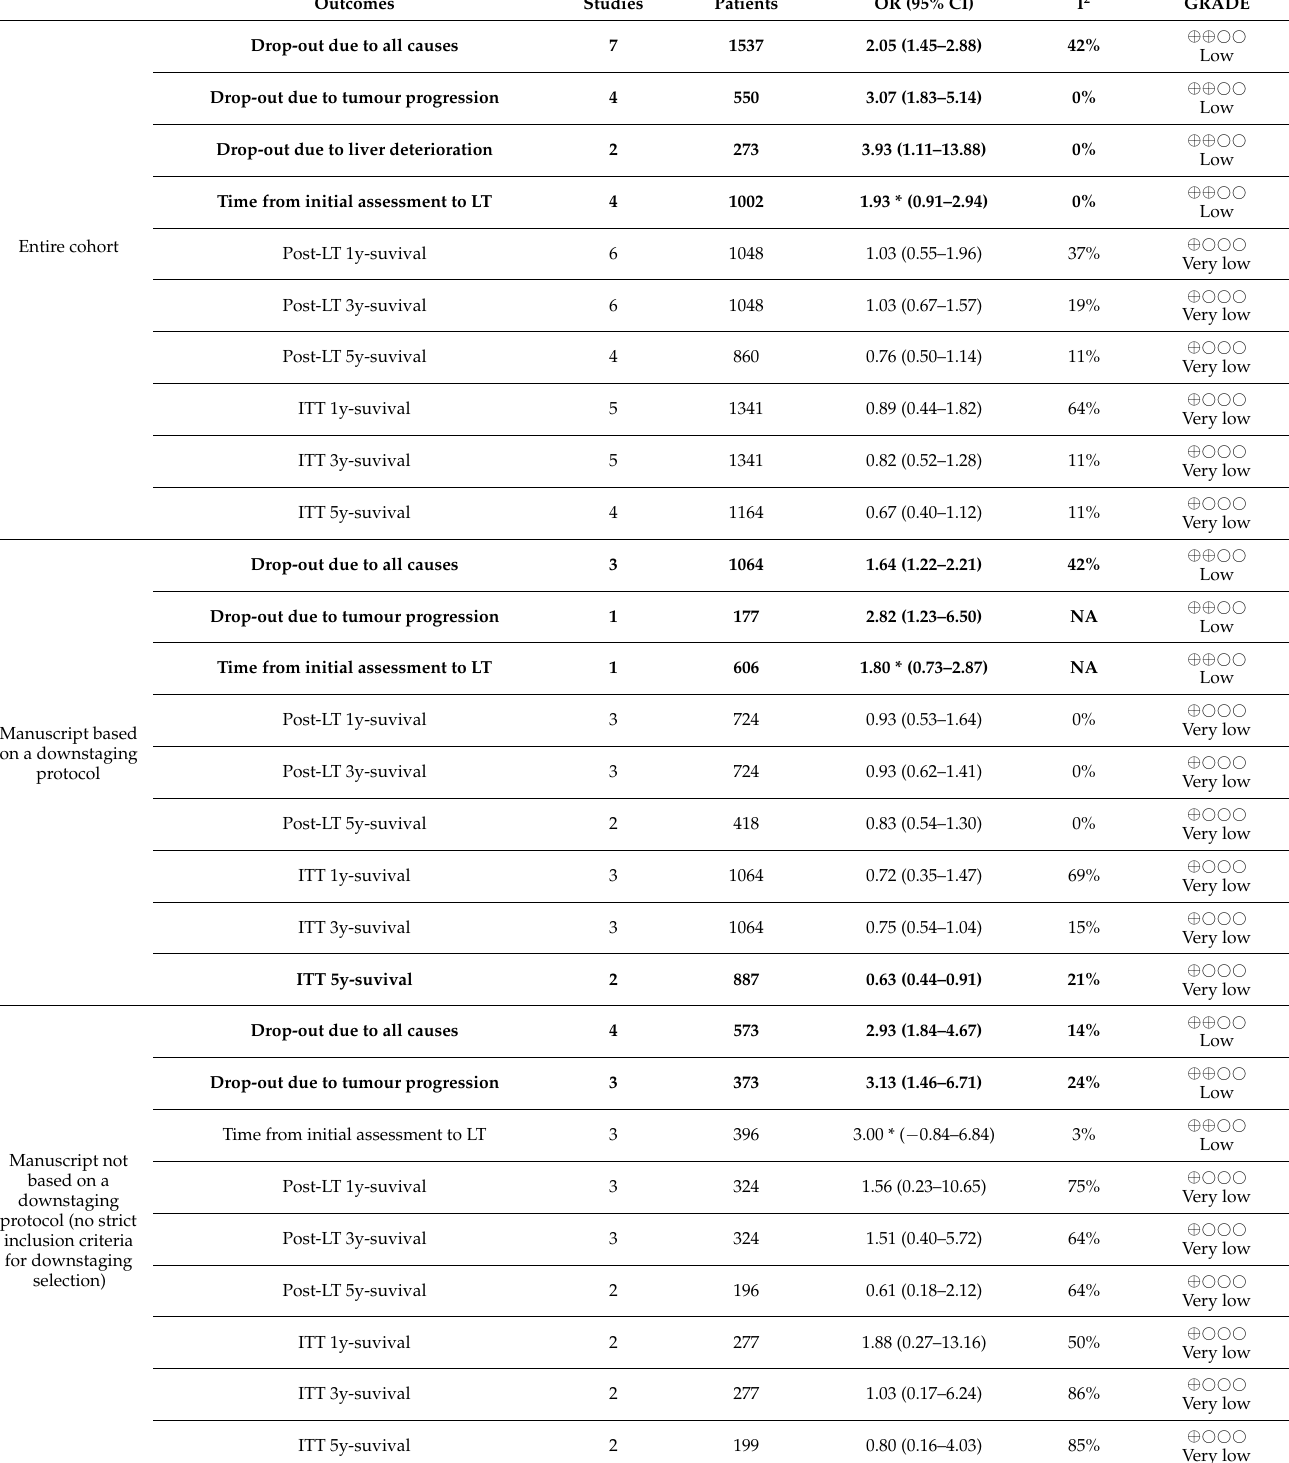
Table 4. Question 1, summary of